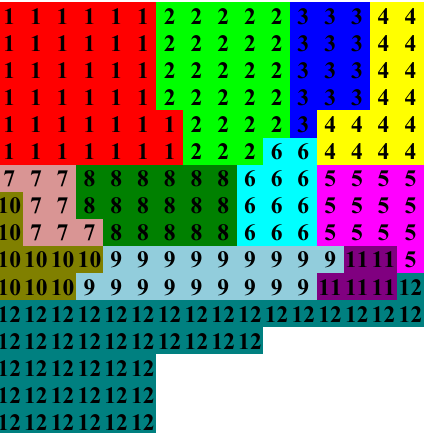
Fig. 12. The best solution obtained by entropy-based algorithm of González-Cruz and Martínez (2011) for Problem 2